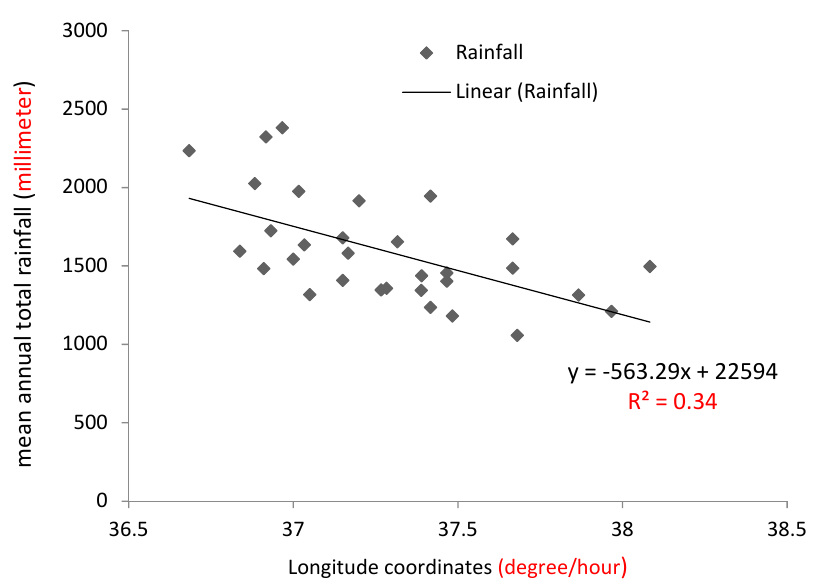
Figure 7. The association between the mean annual total rainfall and the longitude coordinates (east–west direction).